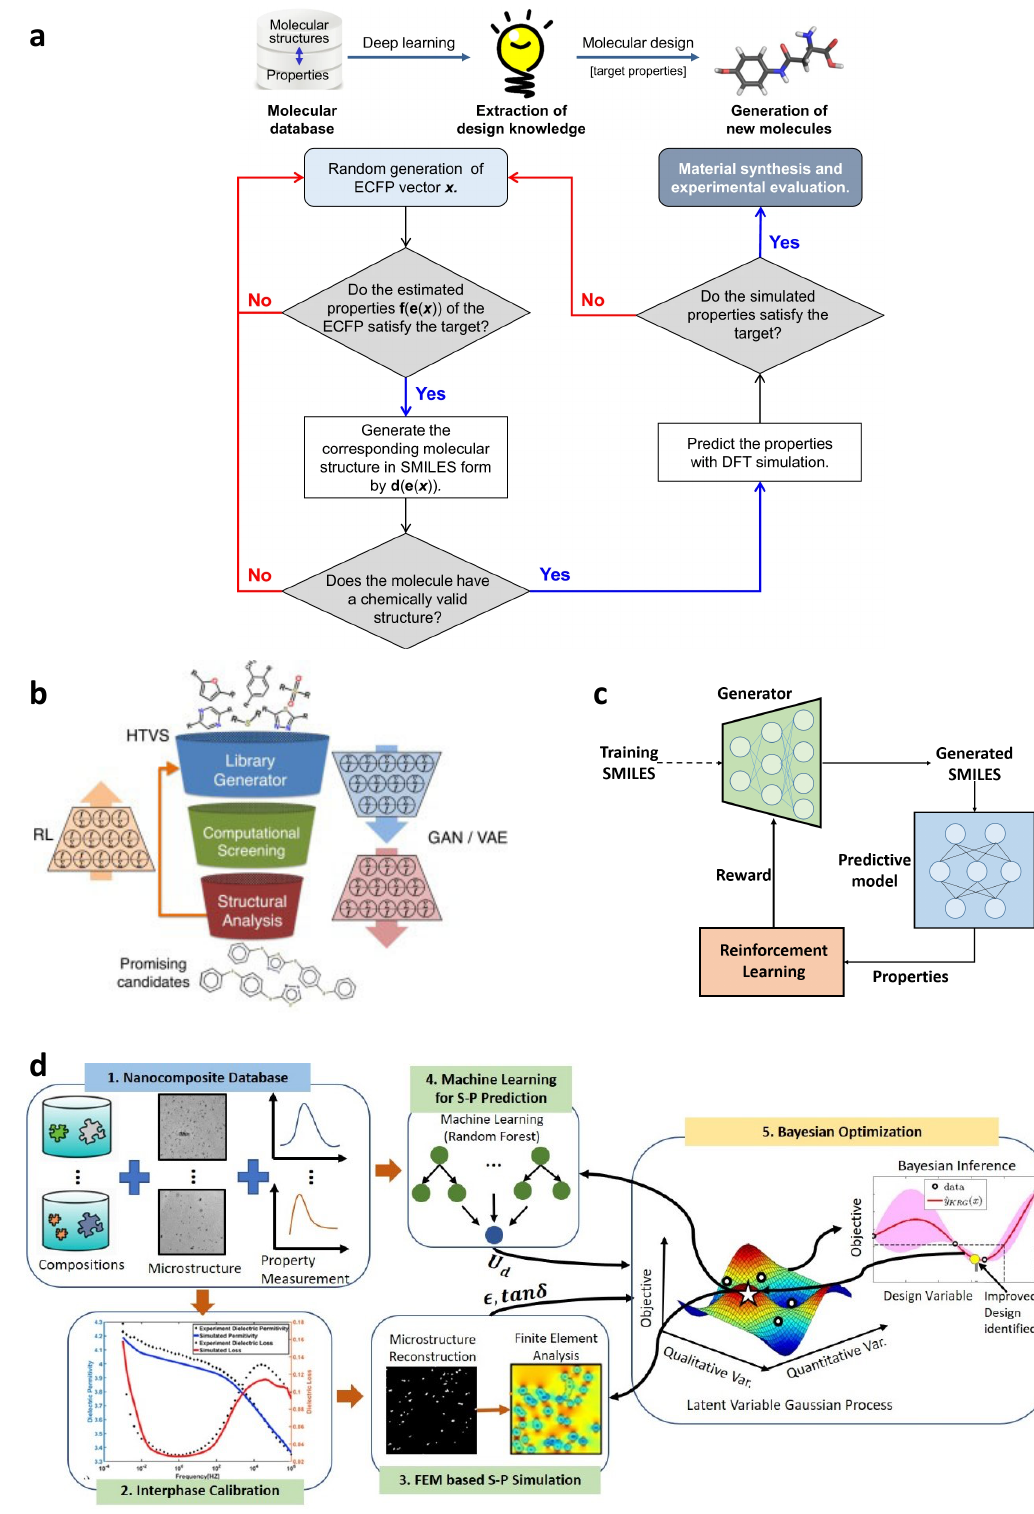
Figure 12. Illustration of materials design approaches. ( a ) ML-assisted materials screening (adapted from Reference [205] with permission, copyright 2018 Springer Nature); ( b ) high-throughput virtual screening integrated with ML models (adapted from Reference [206] with permission, copyright 2019 Elsevier) and ( c ) inverse molecular design by RL; ( d ) integration of various modules for design of insulating nanocomposites by Bayesian optimization (BO). ECFP = extended connectivity